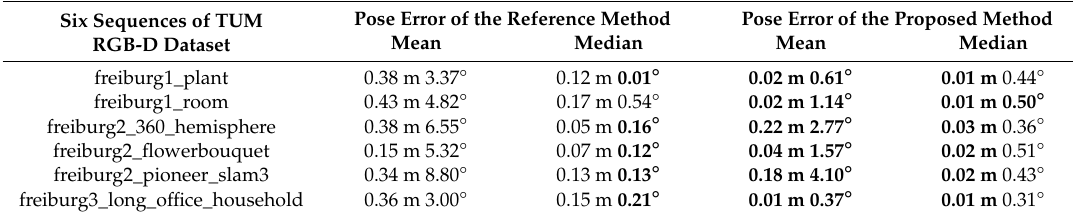
Table 4. The results of position error and attitude error of the six sequences using the reference method and the proposed method. Each term contains a mean error and a median error. The numbers in bold indicate that these terms are better than those of the other